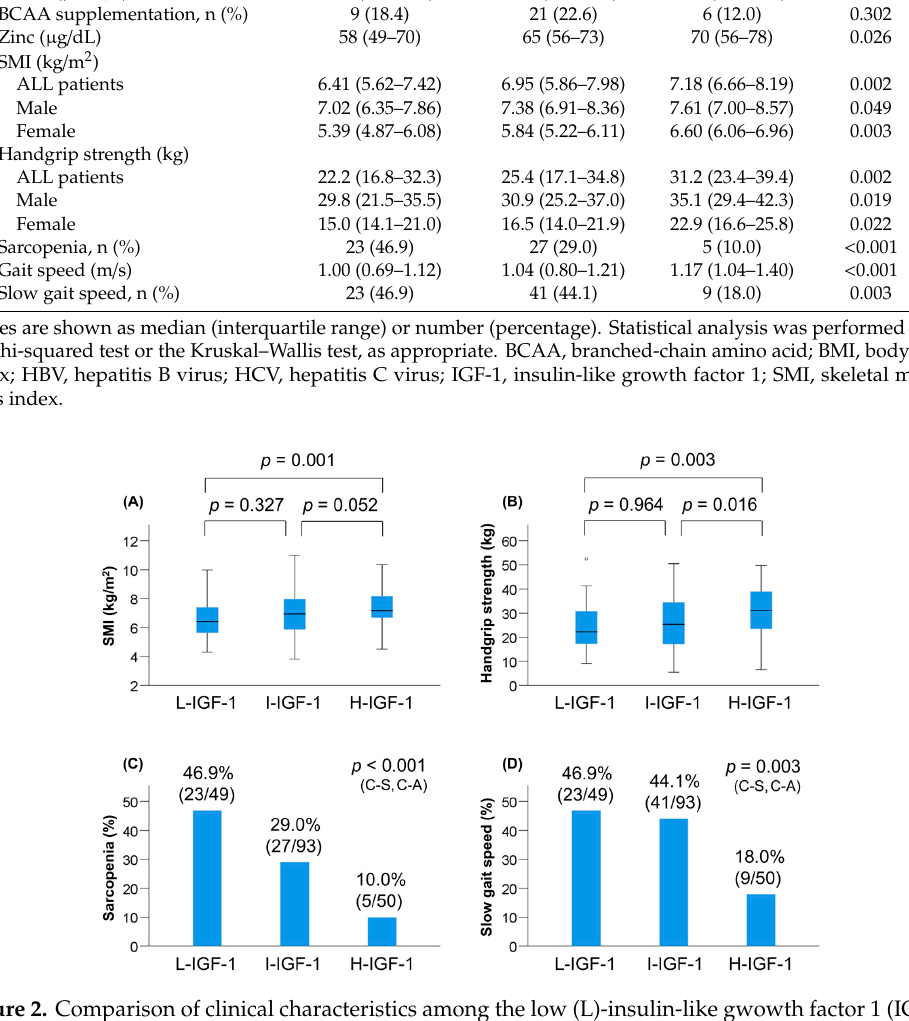
Figure 2. Comparison of clinical characteristics among the low (L)-insulin-like gwowth factor 1 (IGF-1), intermediate (I)-IGF-1, and high (H)-IGF-1 groups. ( A ) Skeletal muscle mass index (SMI) values were significantly lower in the L-IGF-1 group than in the H-IGF-1 group. ( B ) Handgrip strength values were significantly lower in the L-IGF-1 group than in the H-IGF-1 group. ( C ) The L-IGF-1 group significantly showed the highest prevalence of sarcopenia ( p < 0.001 by the chi-squared test), whereas the H-IGF-1 group significantly had the lowest prevalence of sarcopenia ( p < 0.001 by the chi-squared test). The prevalence of sarcopenia significantly increased stepwise with a reduction in the IGF-1 level ( p < 0.001 by the Cochran–Armitage trend test). ( D ) The H-IGF-1 group significantly had the lowest prevalence of slow gait speed ( p = 0.003 by the chi-squared test). The prevalence of slow gait speed significantly increased stepwise with a reduction in the IGF-1 level ( p = 0.003 by the Cochran–Armitage trend test). C-A, Cochran–Armitage trend test; C-S, chi-squared